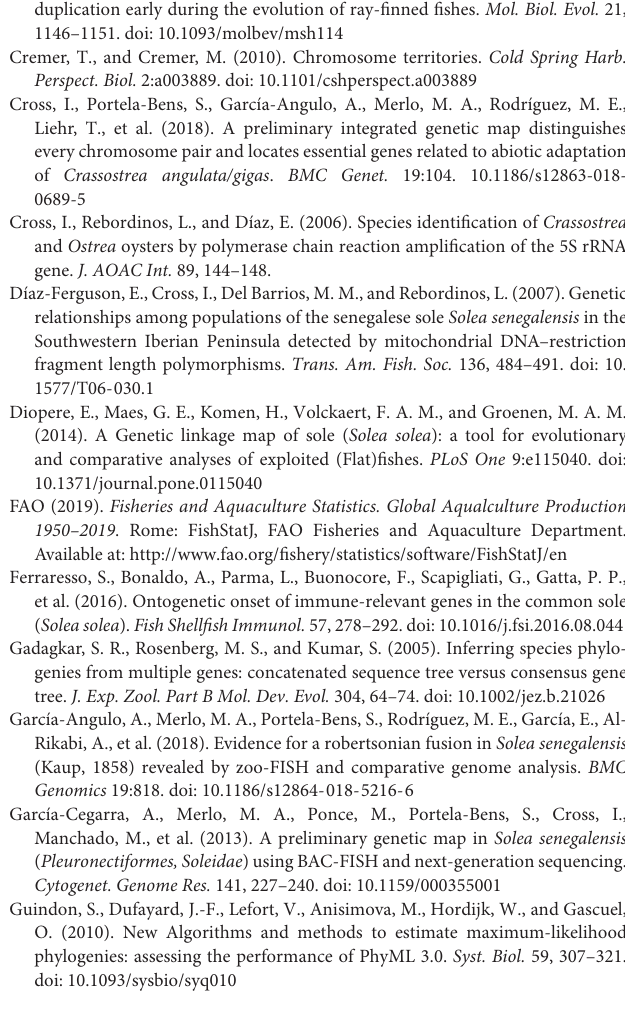
be observed. Each BAC clone is represented in a different color. The genes found by annotation are indicated within each BAC clone and their corresponding localization in the D. rerio chromosomes are denoted by crossing lines. The BAC clones analyzed are given in Table 1 . FIGURE S2 | Circos analysis in the species O. niloticus. On the left side the distribution of the BAC clones of Senegalese sole distributed in chromosomes can be observed. Each BAC clone is represented in a different color. The genes found by annotation are indicated within each BAC clone and their corresponding localization in the O. niloticus chromosomes are denoted by crossing lines. The clones analyzed are given in Table 1 . FIGURE S3 | Circos analysis in the species G. aculeatus. On the left side the distribution of the BAC clones of Senegalese sole distributed in chromosomes can be observed. Each BAC clone is represented in a different color. The genes found by annotation are indicated within each BAC clone and their corresponding localization in the G. aculeatus chromosomes are denoted by crossing lines. The BAC clones analyzed are given in Table 1 . DATA SHEET S1 | Sequences used for the construction of the phylogenetic tree. DATA SHEET S2 | Saturation indices and plots with transitions (s) and transversions (v) for each gene and in the concatenated